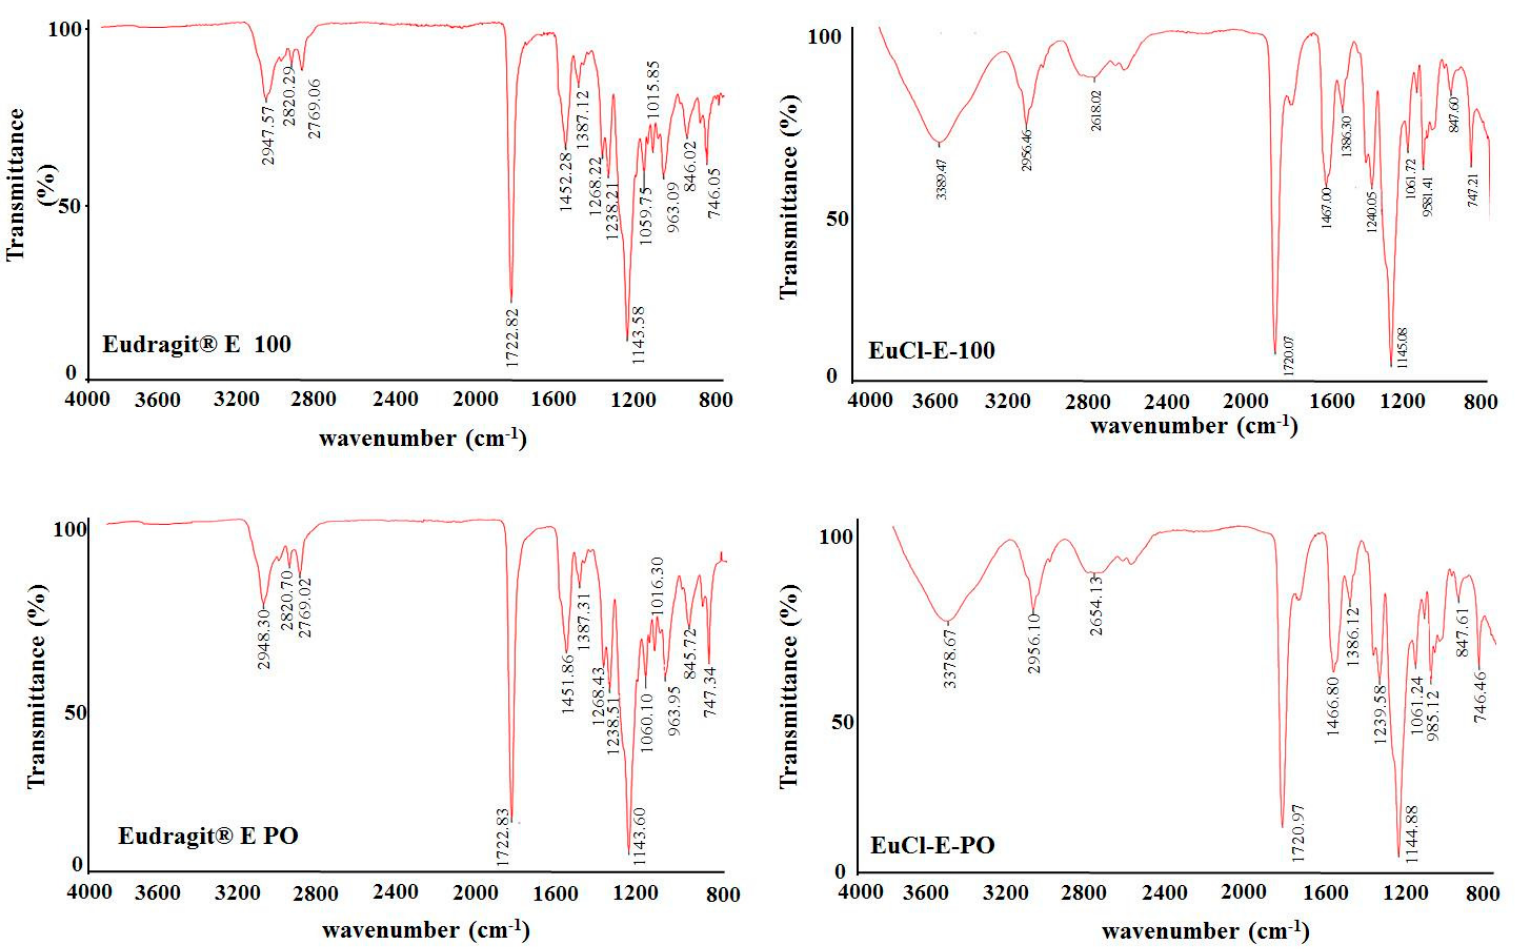
Figure 2. FTIR spectra of polymers derived from Eudragit E-100. 2